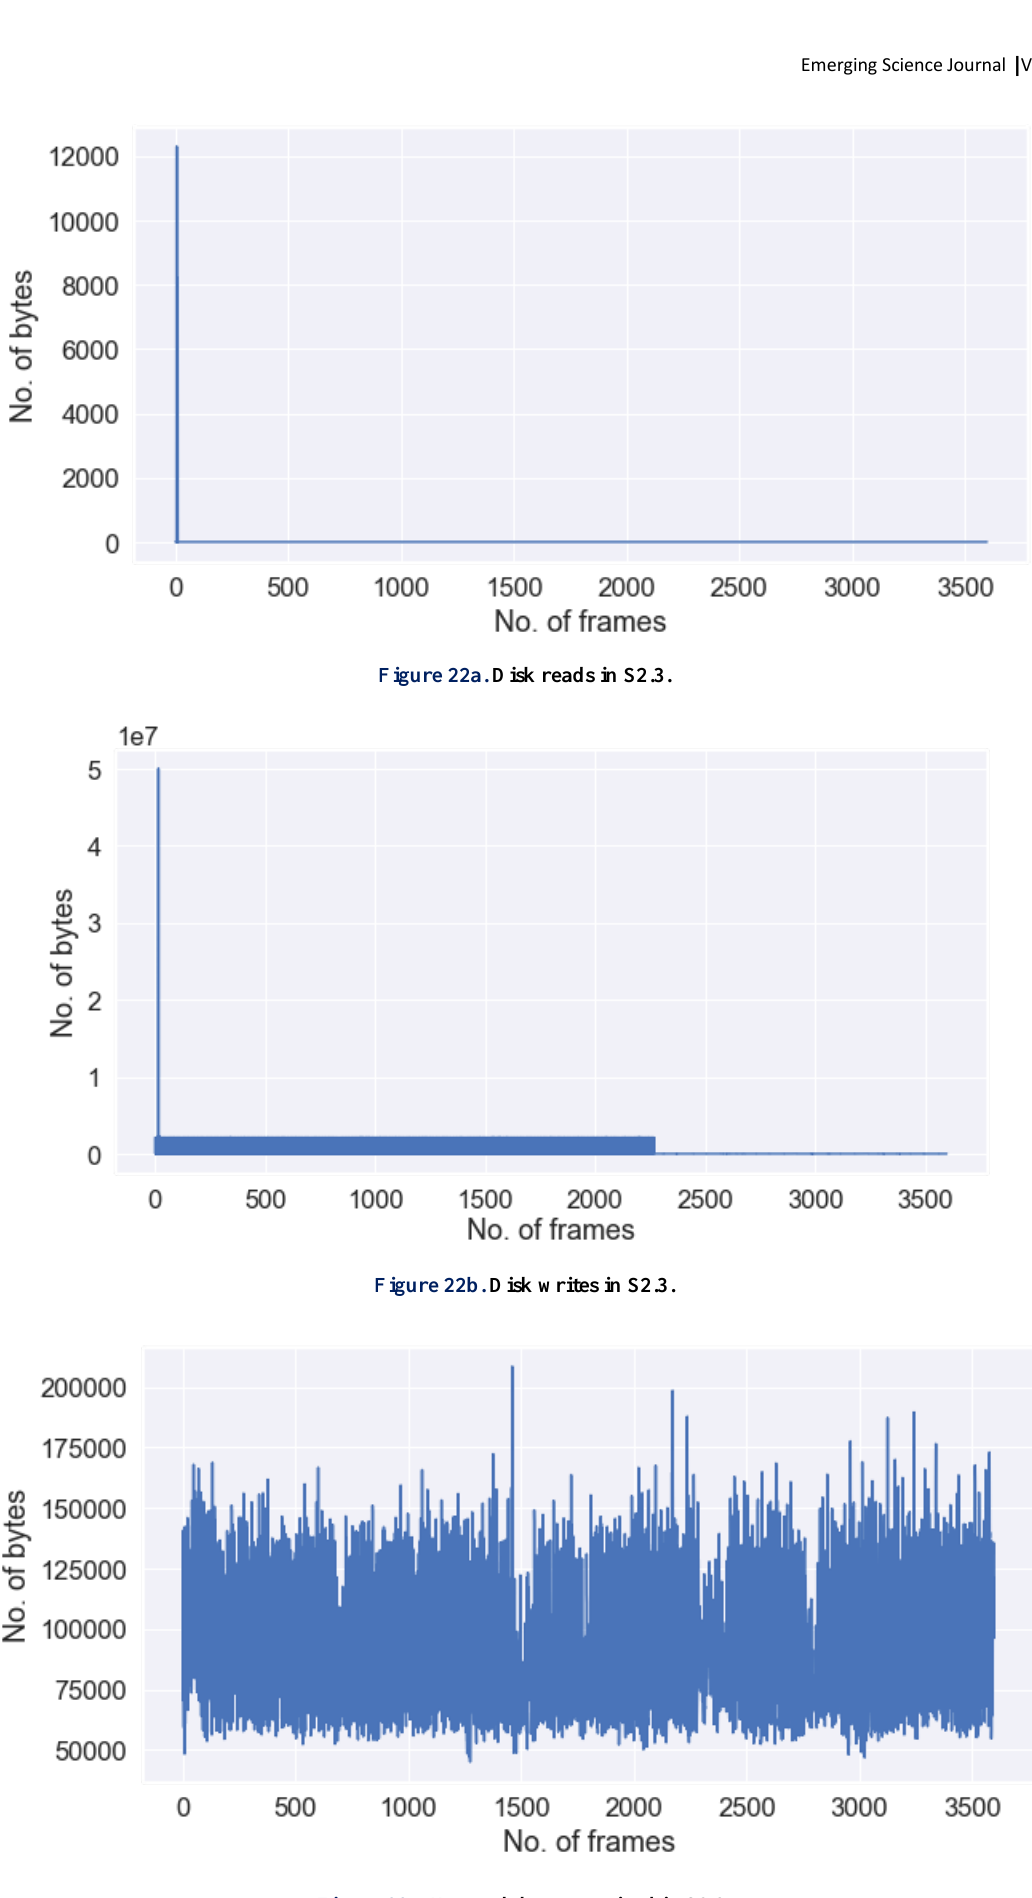
Figure 23a. Network bytes received in